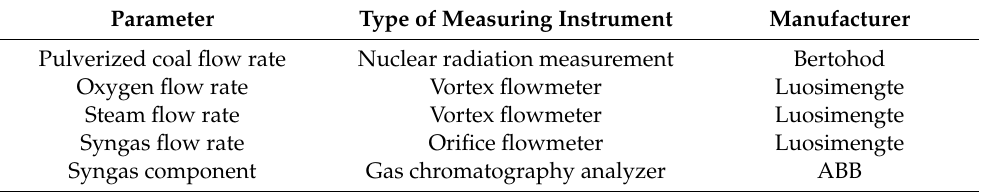
Table 4. The information of measuring